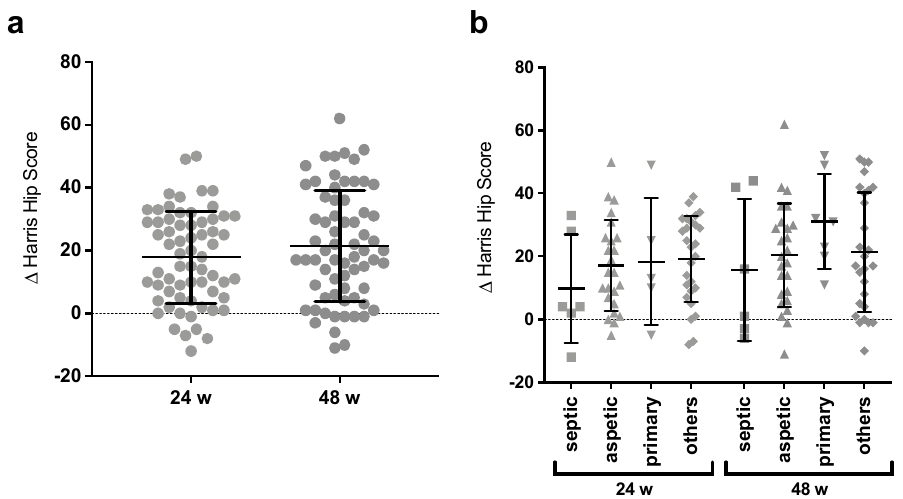
Figure 2. The clinical outcome after 24 and 48 weeks with ( a ) the ∆ HHS development of all patients; ( b ) differences for subgroups. Clinical improvement could be seen for >85% of patients. The greatest improvements were up to 24 weeks and afterward; mainly, little adjustments and a widening of spread took place. Furthermore, a clinical improvement occurred in all subgroups, after 48 weeks the largest for the primary implantation patients, and the smallest for patients after septic loosening. No significant differences were seen between the groups.